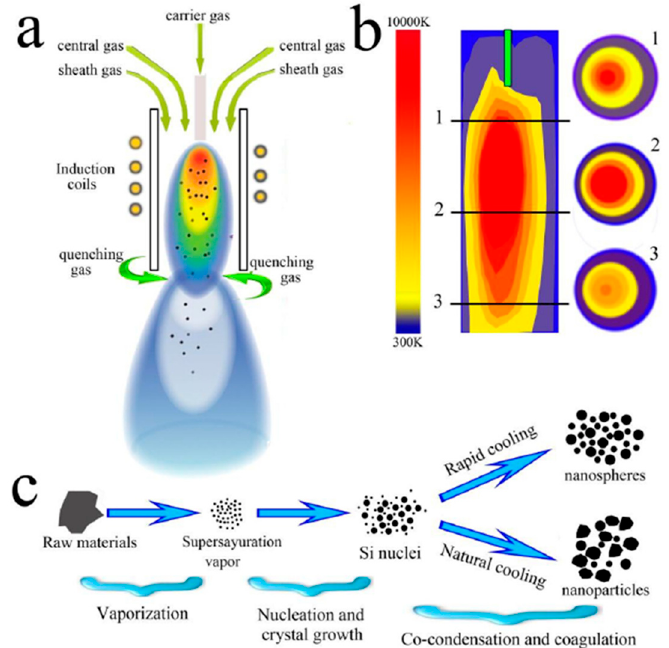
Table 2. Comparison list between the characteristics of plasma process and the properties of ZrB 2